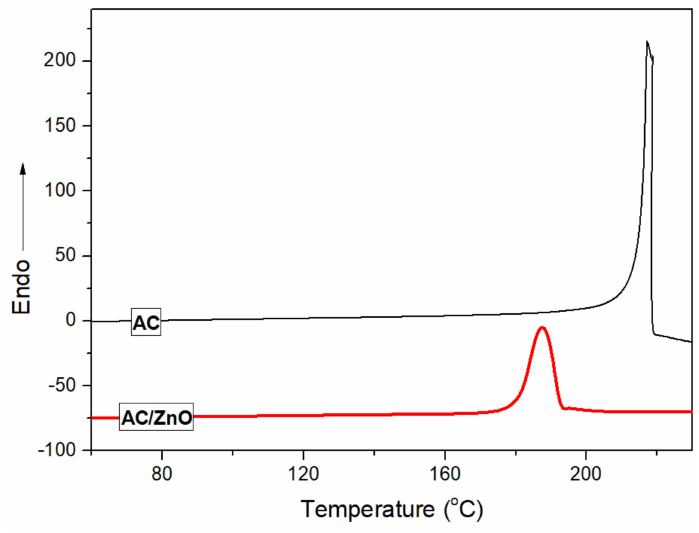
Figure 1. The heating flow curve of AC and AC/ZnO at a heating rate of 10 ◦